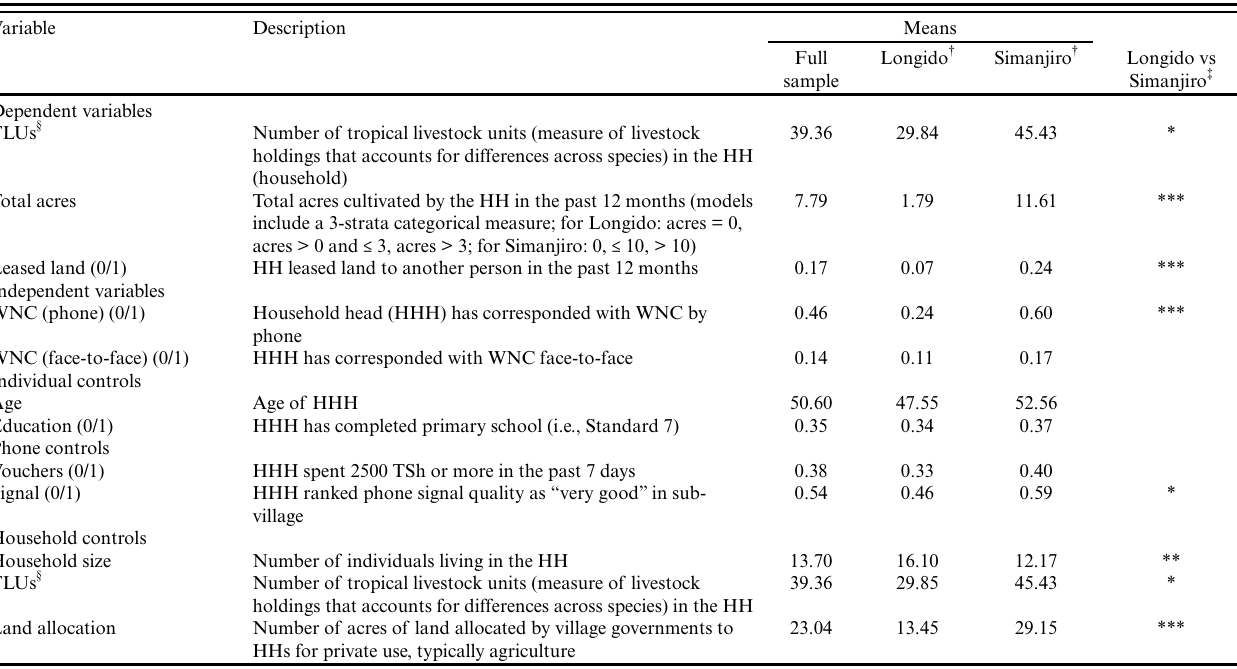
Table 1 . Descriptions and means for variables used in regression analyses, including means stratified by district and significance tests for difference in district means. WNC = wrong number